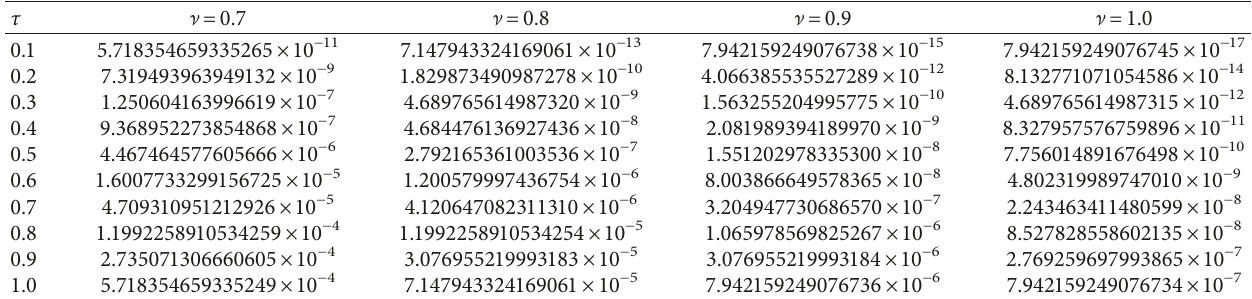
Table 9: The recurrence error of the 5th approximate solution of the real part in Example 3.